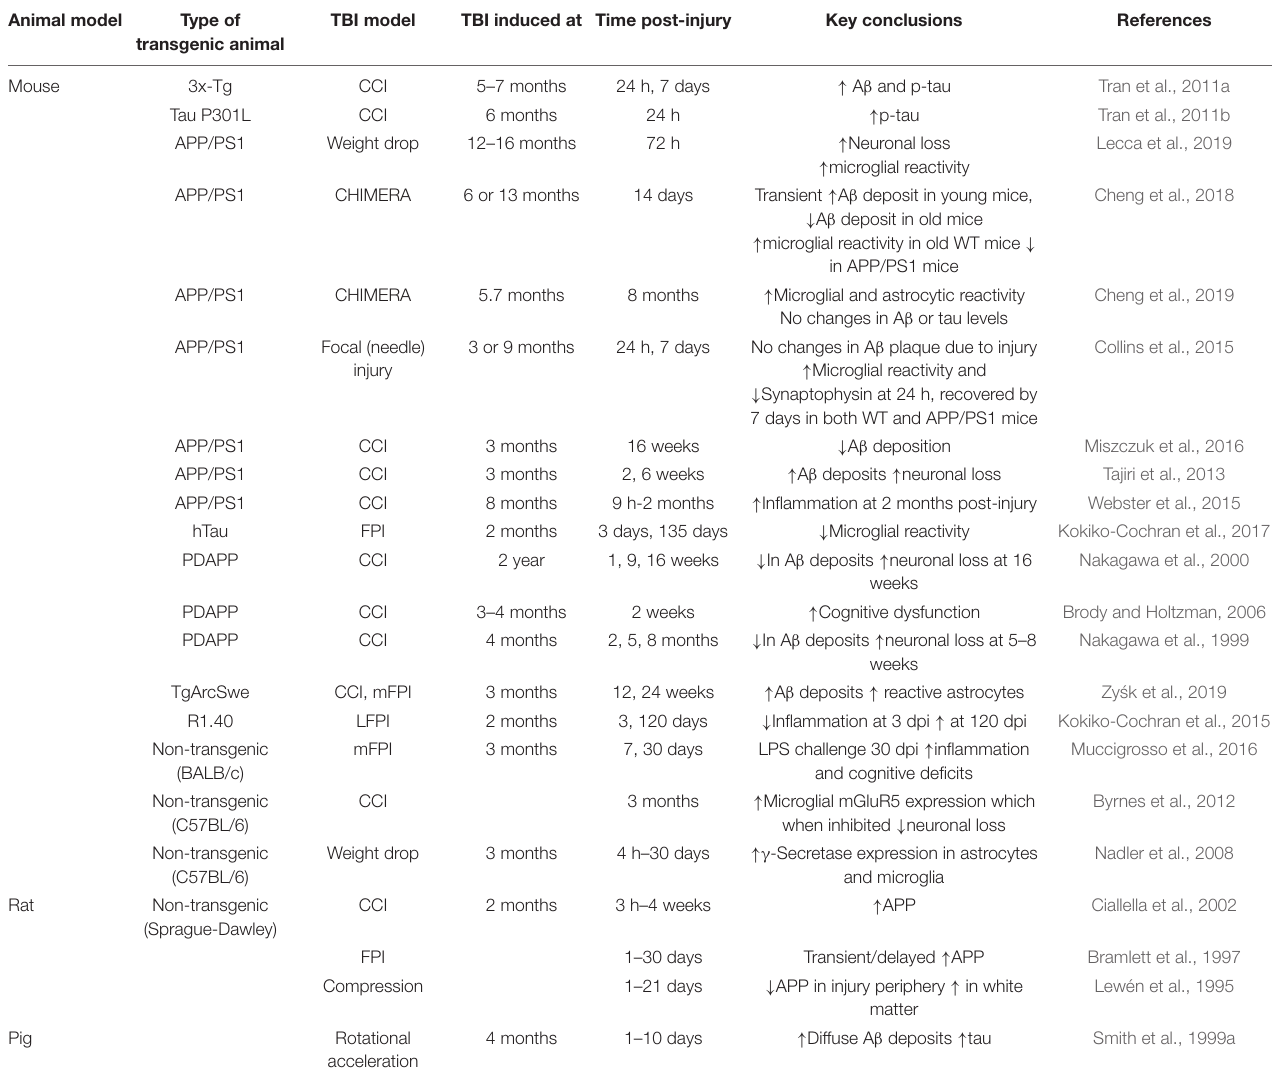
TABLE 1 | Summary of AD phenotypes observed in animal models of